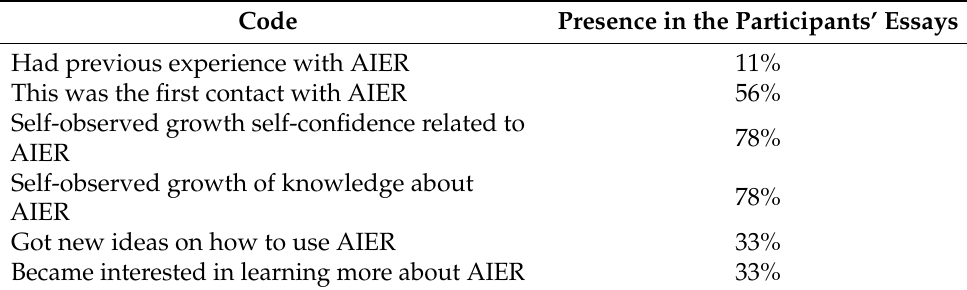
Table 2. Presence of AIER related codes in participants’